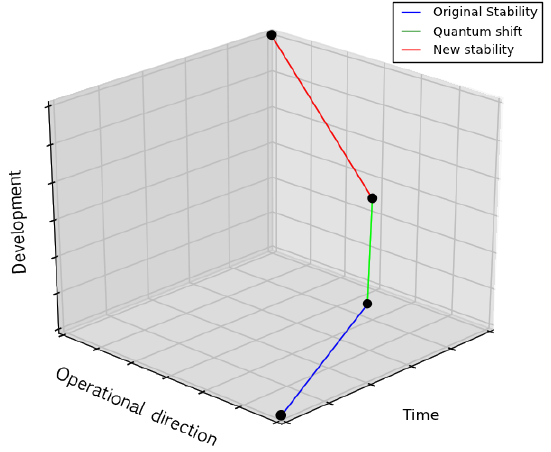
Figure 2. A quantum shift that includes a possible change in operational